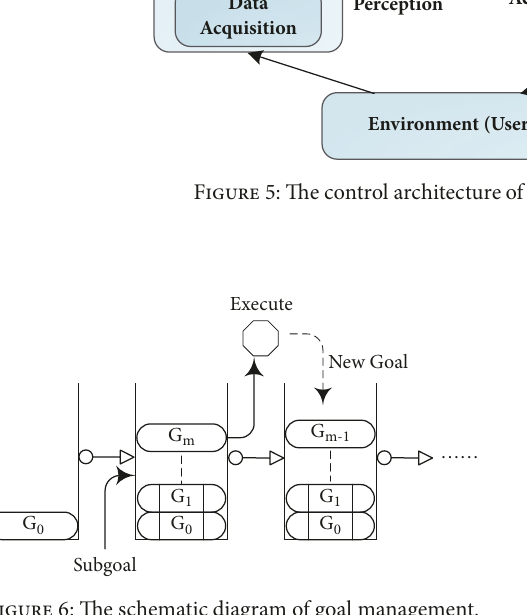
Figure 6: The schematic diagram of goal